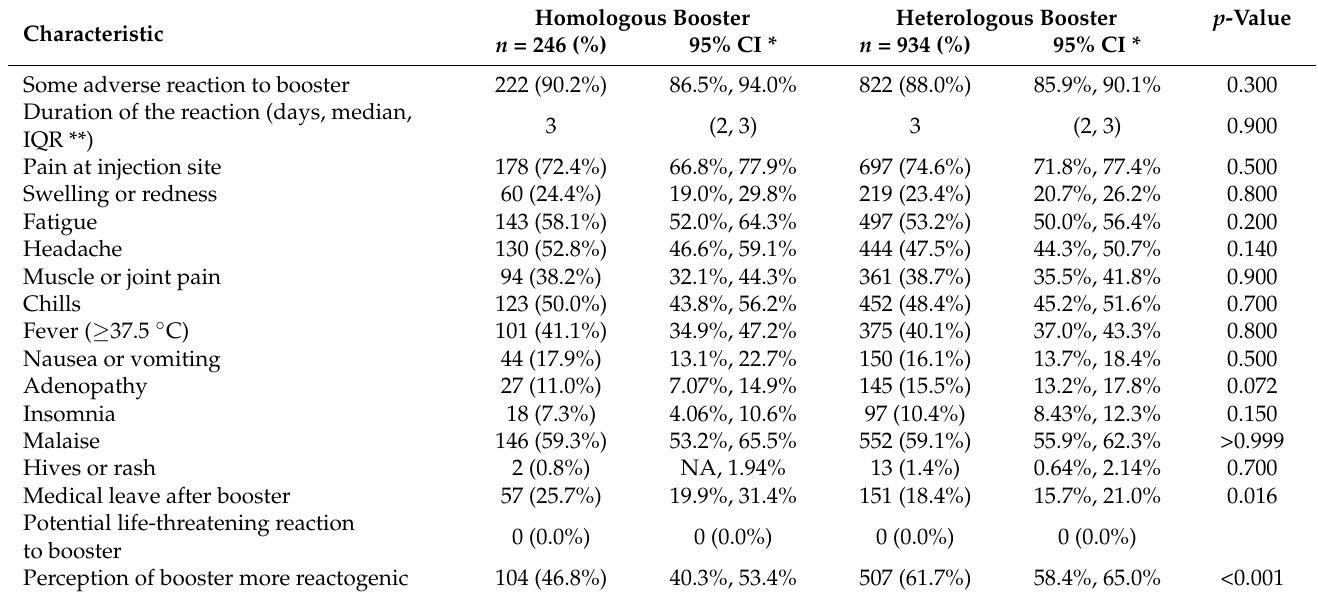
Table 3. The self-reported adverse reaction to the COVID-19 booster when comparing the homologous booster versus the heterologous booster.